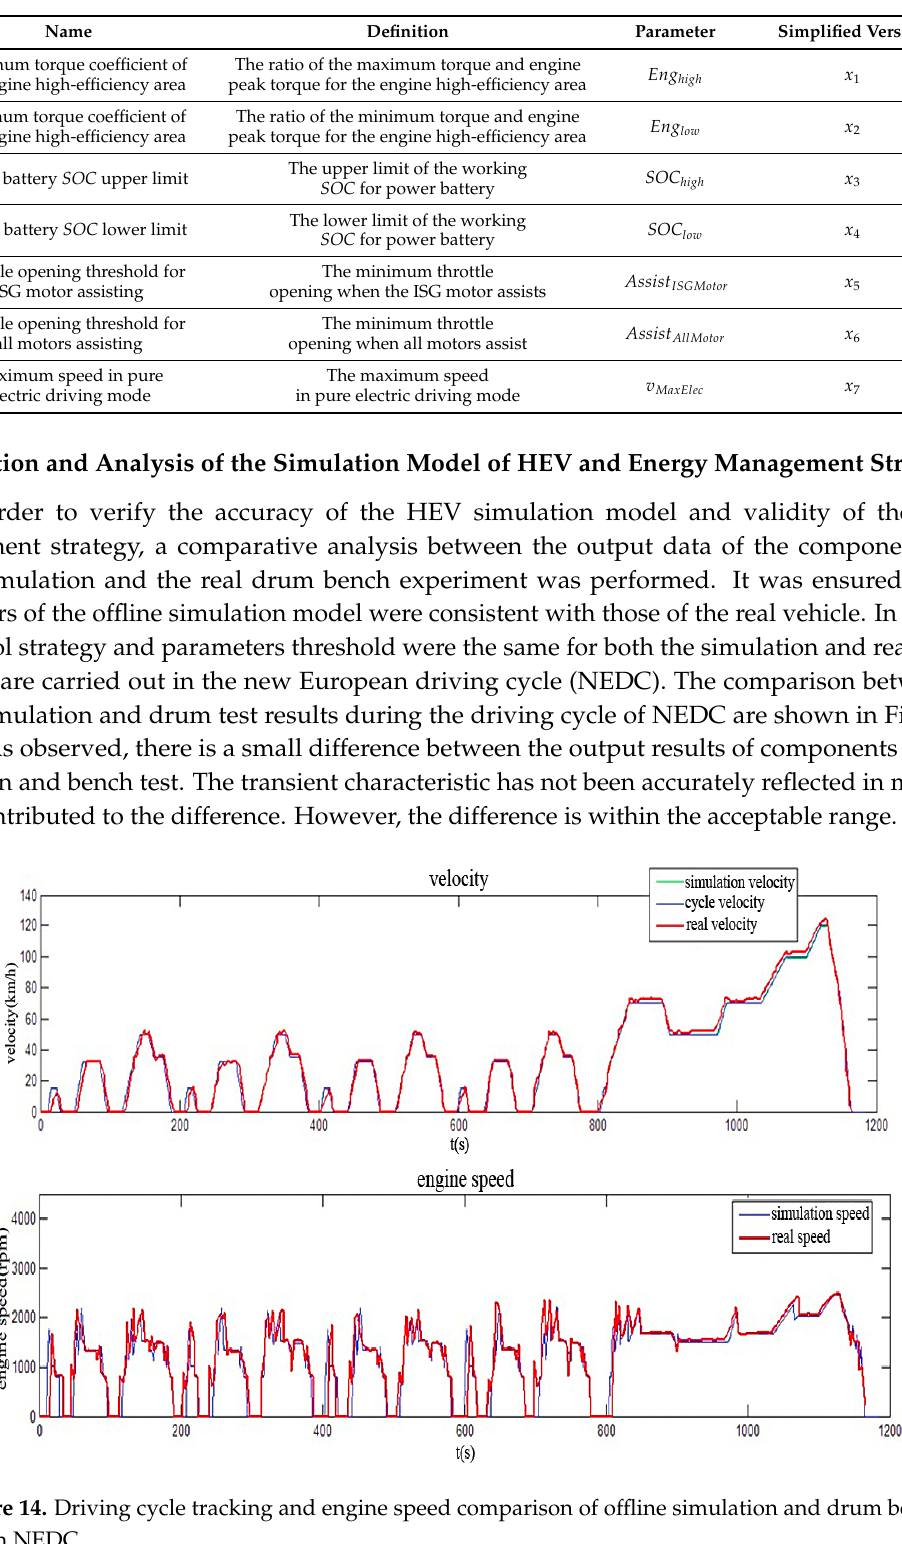
Table 9. Key parameters of logic threshold energy management strategy.